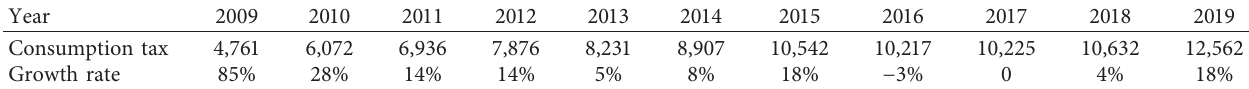
Table 6: China’s domestic consumption tax income and growth rate (2009–2019). Unit: RMB 100